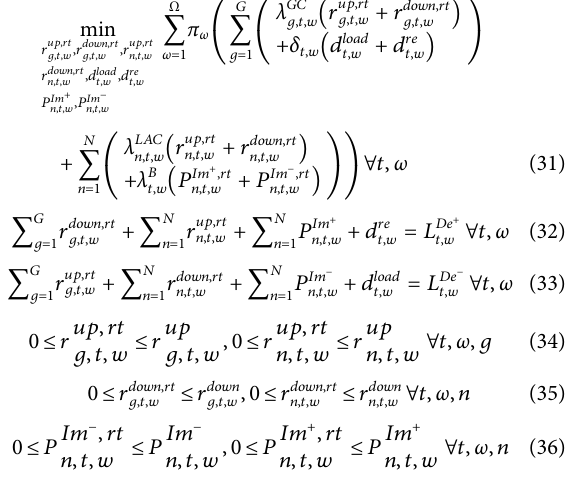
Figure 6A. Scenario two: the real-time load is much more than the day-ahead prediction as shown in Figure 6B.